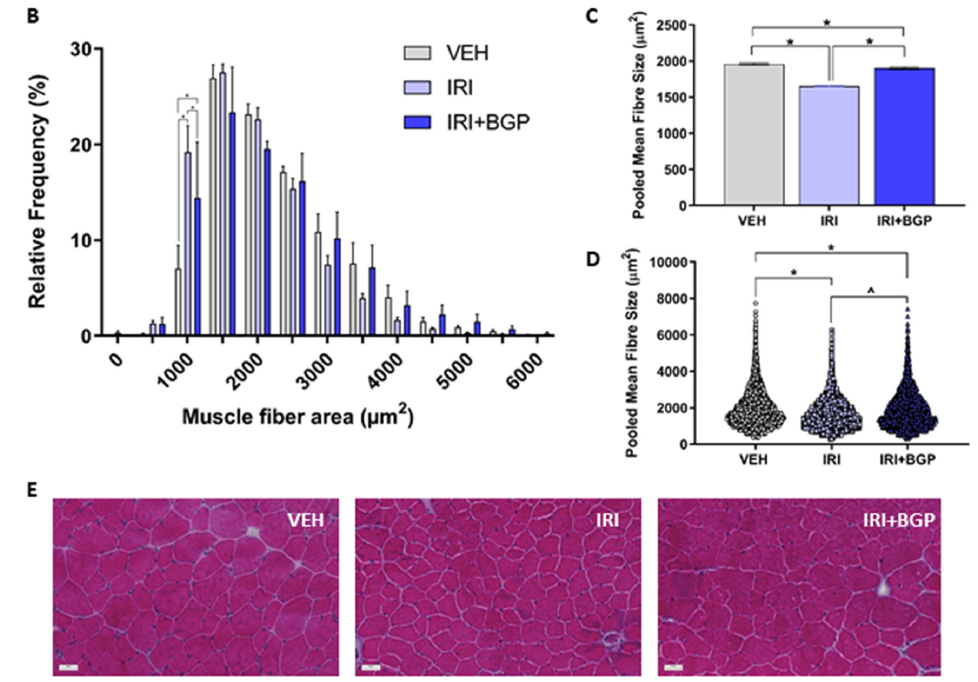
Figure 2. The effect of irinotecan (IRI) and IRI with BGP-15 (IRI+BGP) treatment on muscle mass and fiber size. ( A ) Skeletal muscle masses of extensor digitorum longus (EDL), soleus (SOL), tibialis anterior (TA) and heart were measured post-mortem and are presented as both raw mass and as a muscle mass to body mass ratio. TA cross-sections were hematoxylin and eosin (H&E)-stained to assess the skeletal muscle histological fiber size with data presented as ( B ) muscle fiber cross-sectional area (CSA) percentage relative frequency distribution, ( C ) the mean group pooled muscle fiber CSA (of all fibers counted) and ( D ) the group pooled fiber size distribution. ( E ) Representative images of H&E-stained TA cross-sections show no evidence of muscle damage (e.g., centronucleated fibers and immune cell infiltrate). Scale bar = 50 µm; * = p < 0.05 compared to VEH, ^ = p < 0.05 compared to IRI; n = 6–8 for muscle weights; n = 4–6 for histology.